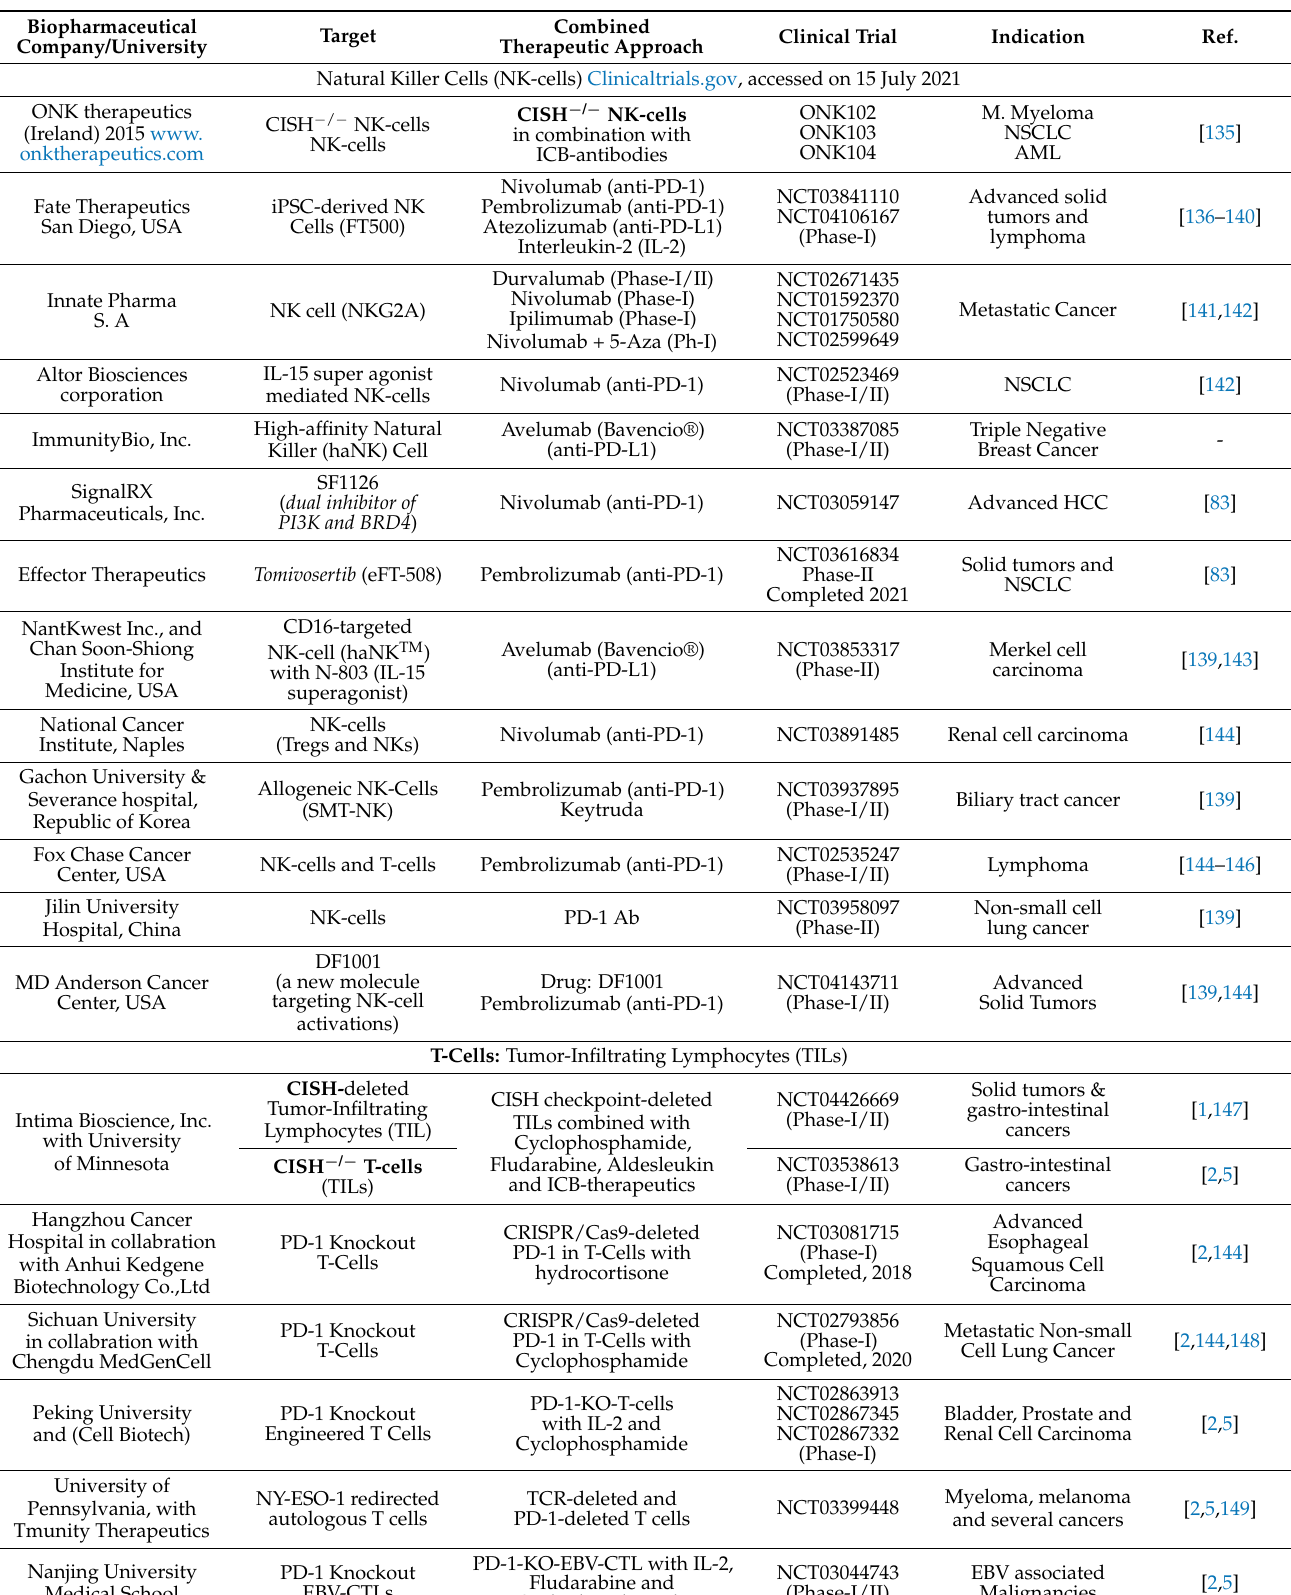
Table 3. Biotech companies/Universities entering into personalized medicine targeting intracellular immune checkpoints in combination with